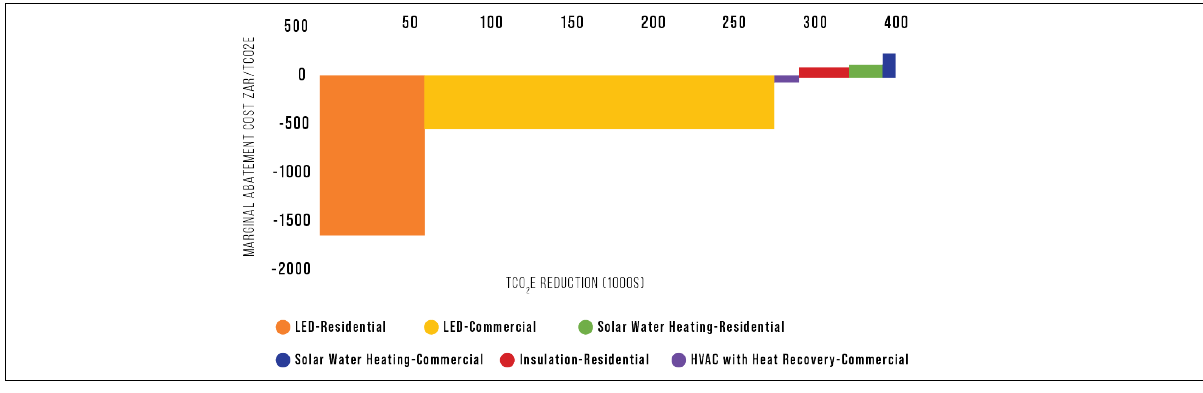
Figure 1: Marginal abatement cost curve for the building sector in 2030.